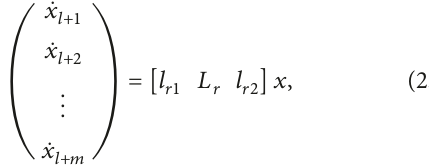
Figure 4: A graph with nontrivial